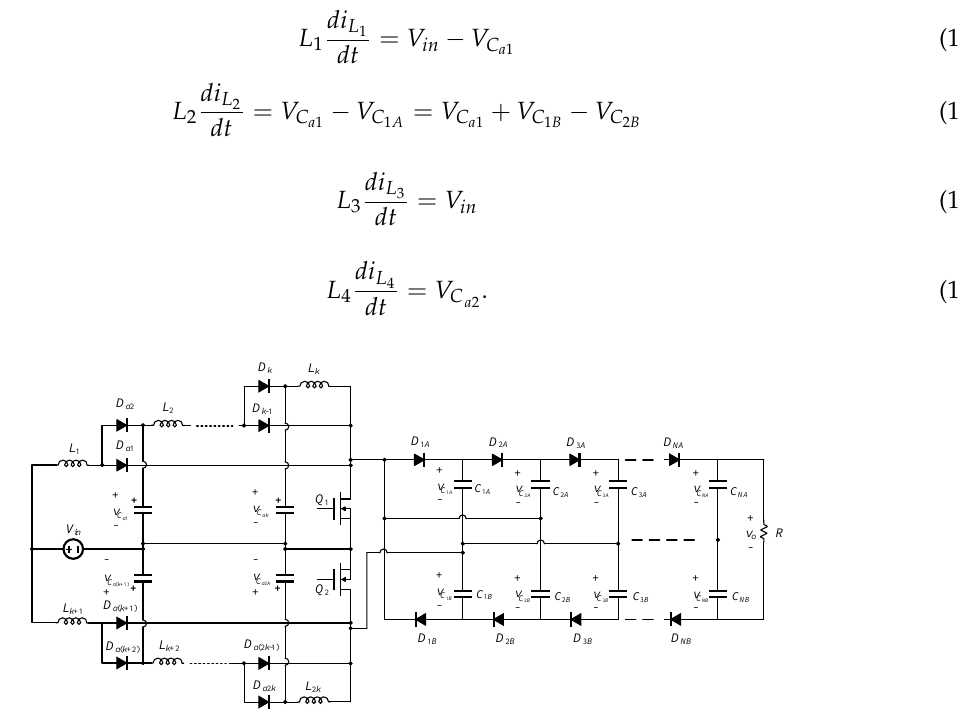
Figure 4. Schematic of the proposed converter with k boost stages and N voltage mutliplier cells. The voltage gain is 2 N ( 1 − d ) k